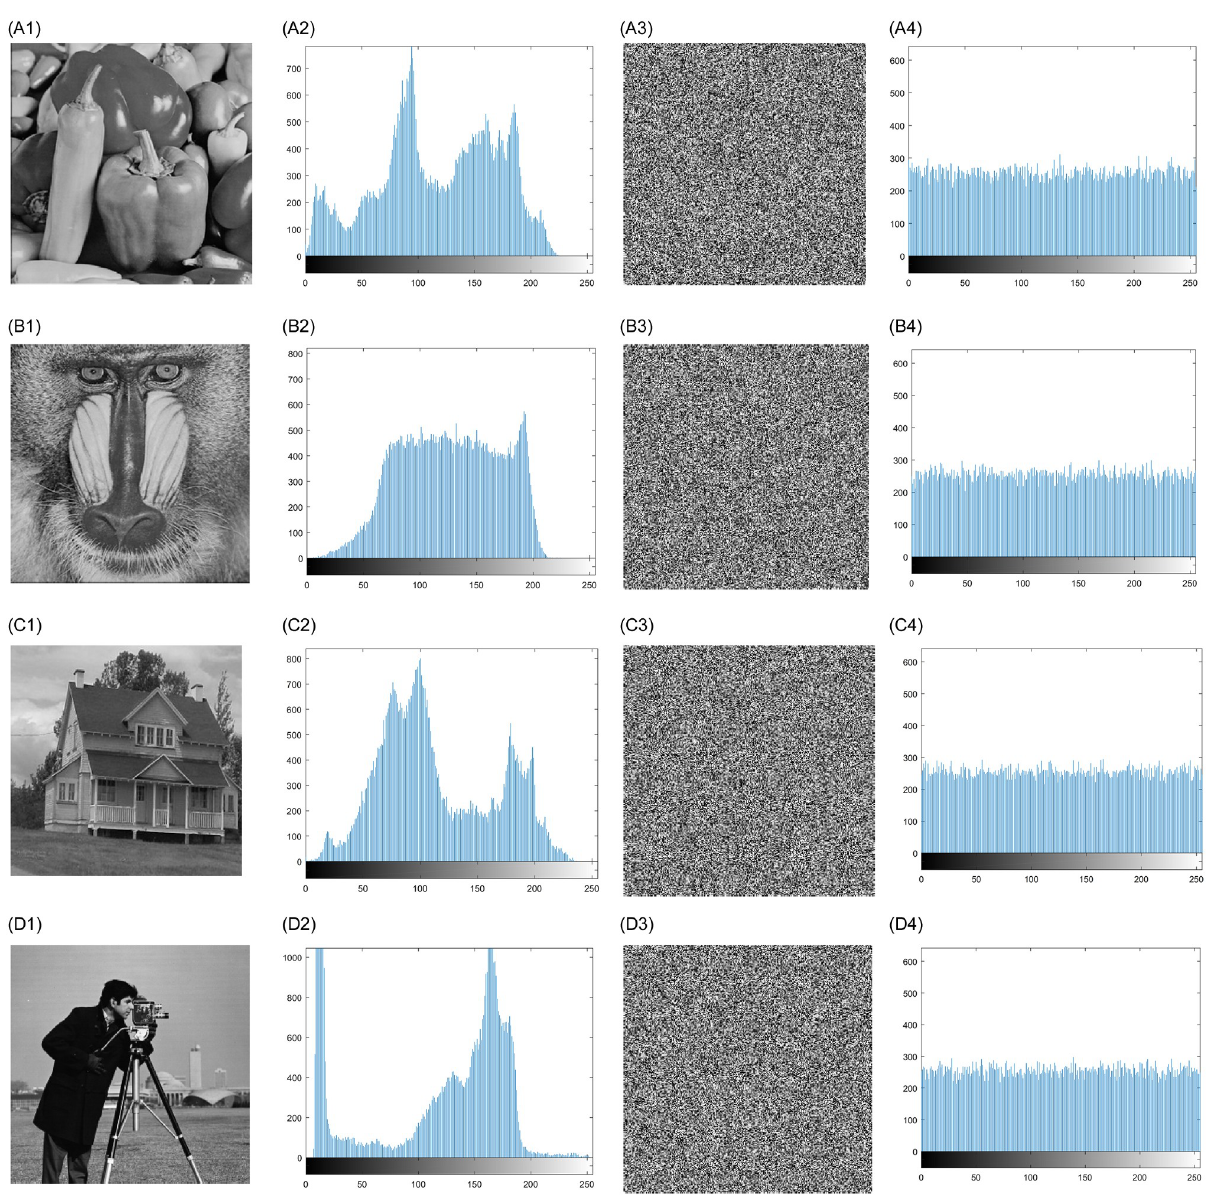
Fig 9. Histogram analysis of original and encrypted images. A1-D1: Original images of Peppers, Baboon, House and Cameraman. A2-D2: The corresponding original image histograms. A3-D3: The encrypted images of Peppers, Baboon, House and Cameraman. A4-D4: The corresponding encrypted image